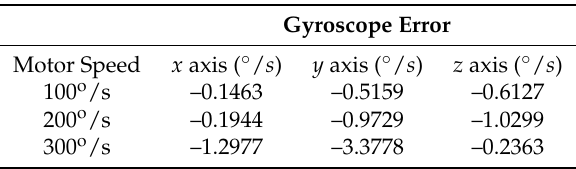
Table 4. X-Sens rotational speed measurement error summary.